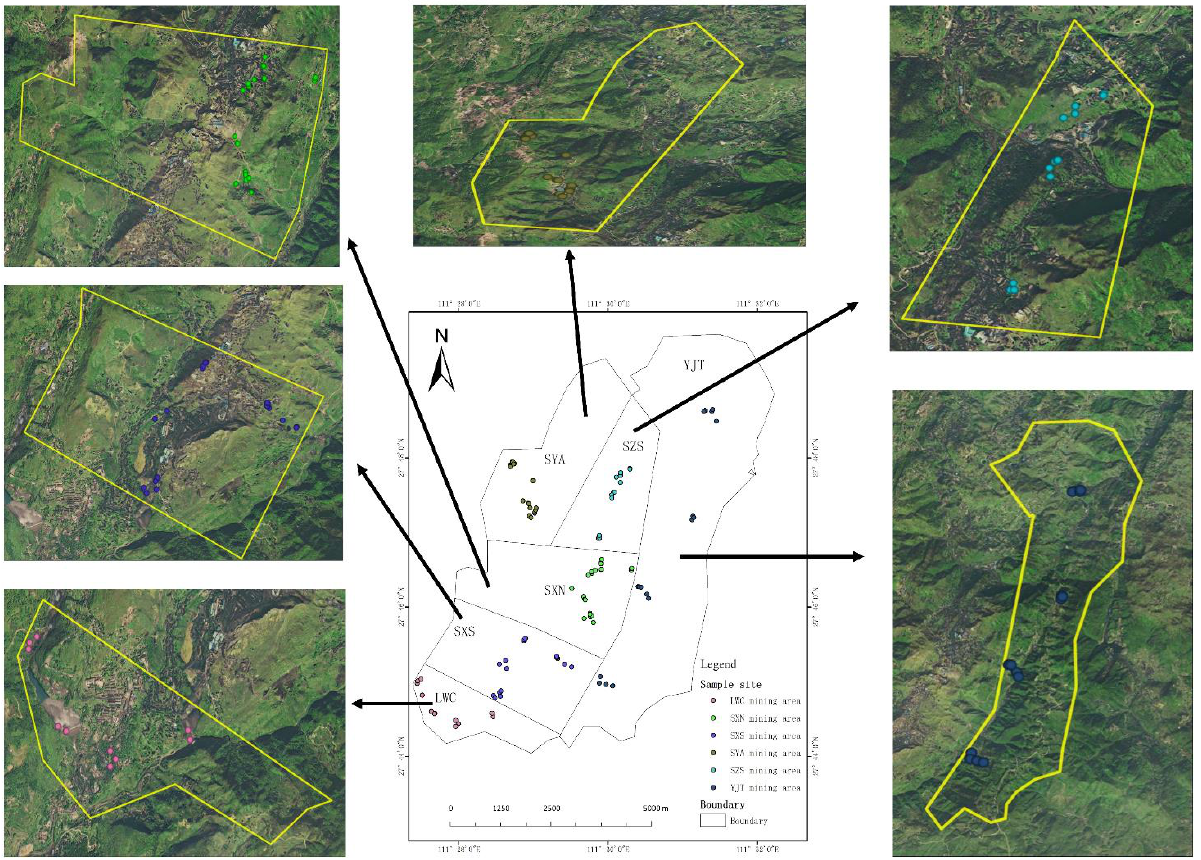
Figure 1. The sampling sites. Yanjingtang Reservoir (YJT), Shizishan Antimony Company (SZS), Lengshuijiang Senyi Antimony Industry (SYA), northern mine of the Twinkling Star Antimony Company (SXN), southern mine of the Twinkling Star Antimony Company (SXS), Longwangchi (LWC).